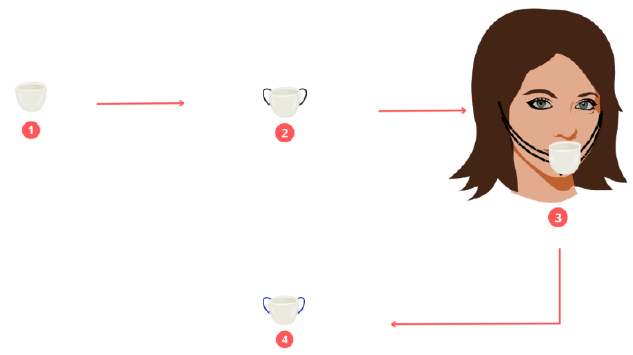
Figure 8. Breathing air sampling.